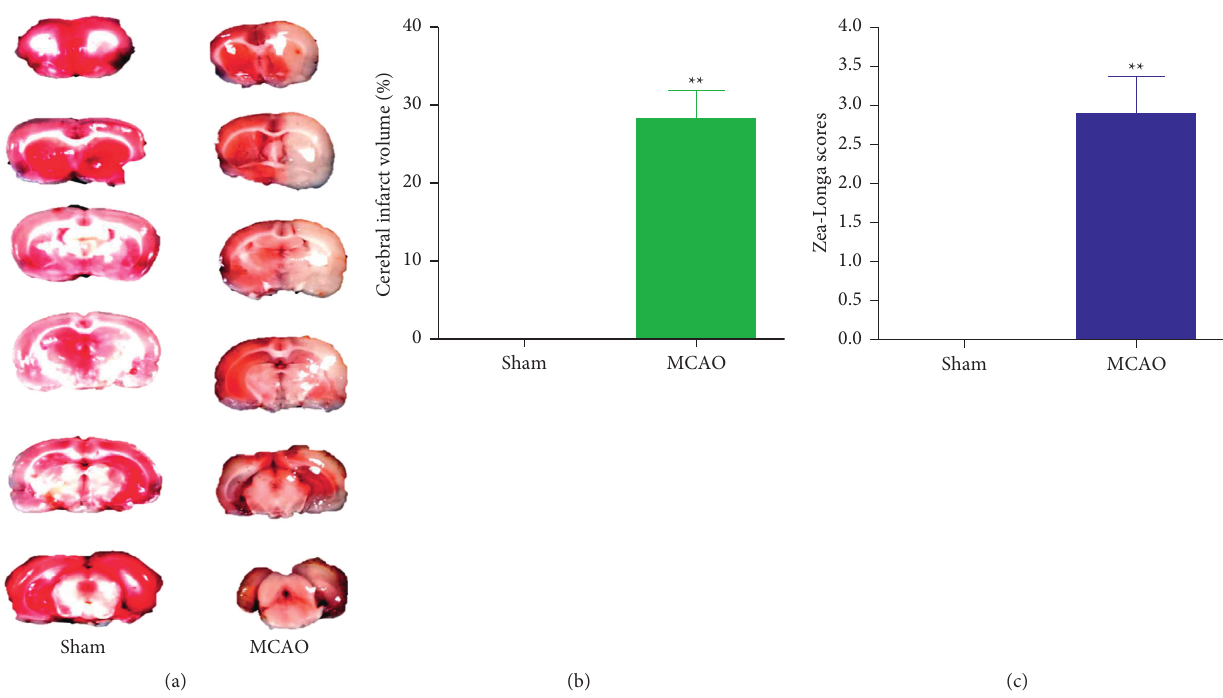
Figure 2: TTC staining results of the representative brain tissue (a), cerebral infarct volume (b), and Zea-Longa scores (c). Compared to sham group, ∗∗ P <